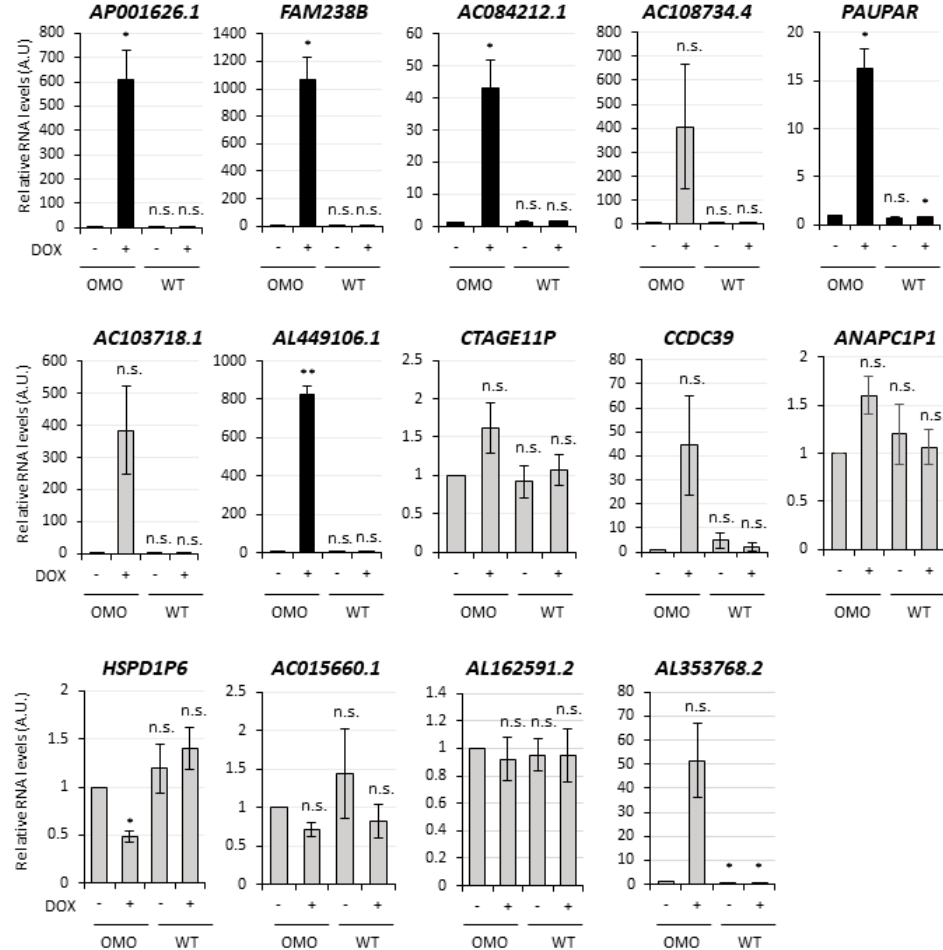
Figure 4. Validation of the MYC-dependent lncRNAs upregulated by OMOMYC in D283 MED cells. qRT-PCR analysis in D283-OMO cells 72 h treated with DOX (OMO+) of the most expressed and upregulated lncRNAs, according to the RNA-Seq (see Dataset S4). Among the 20 top hits from the table, 14 RNAs were successfully detected and included in the figure. Expression levels were compared to untreated D283-OMO (OMO − ) as control, set as 1. Validated candidates (5 lncRNAs) are indicated by black histograms, non-validated candidates (9 lncRNAs) are reported in grey. Data (means ± SEM) are expressed in arbitrary units and are relative to ATP5O mRNA levels. N = 3, * p ≤ 0.05, ** p ≤ 0.01 (two- tailed Student’s t -test).